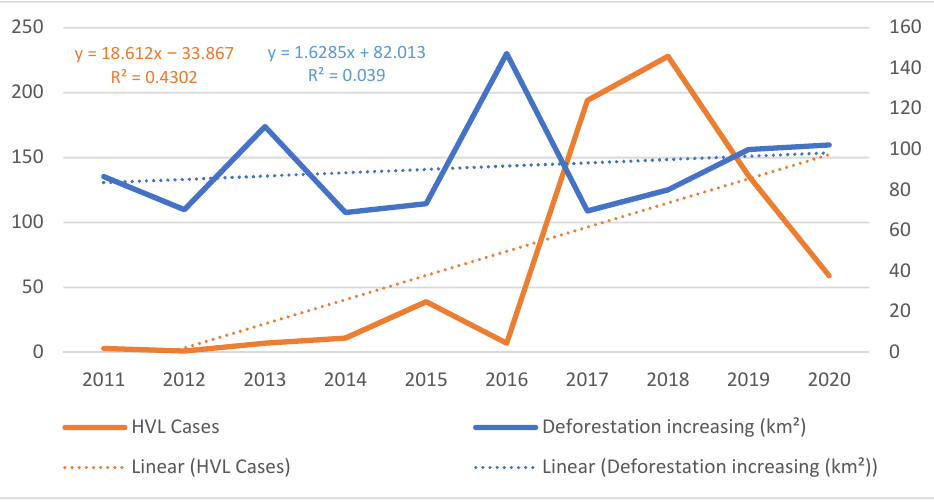
Figure 5. Relationship between the annual increase in deforestation and the number of HVL cases in the Carajás Integration Region, Pará, Brazil, for the period of 2011 to 2020.